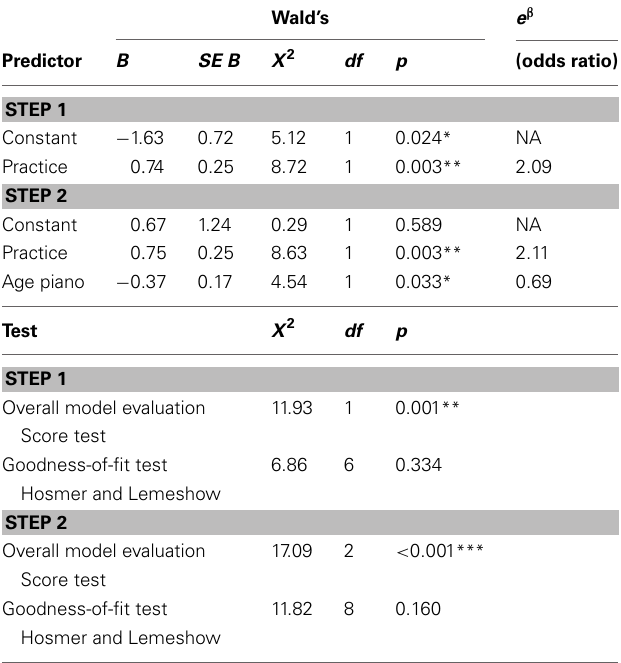
Table 6 | Regression coefficients and overall model evaluation for a logistic regression analysis using seven predictors to model high achievement in piano performance ( N =